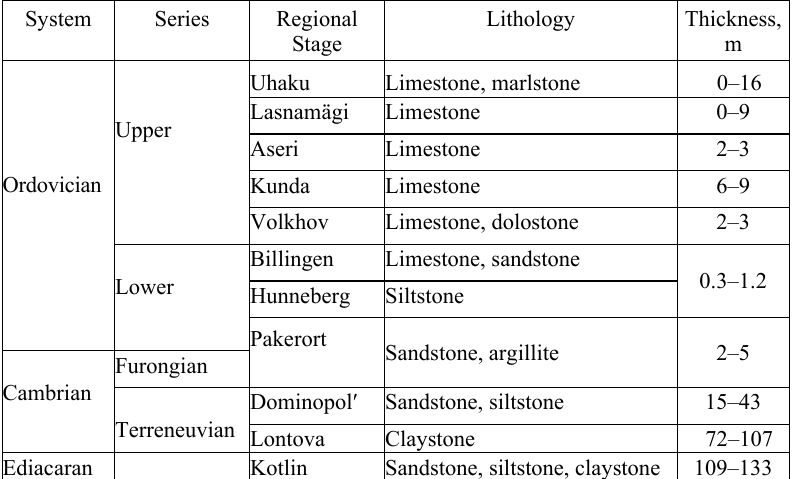
Table. 1. Sedimentary bedrock of the area (Raukas & Teedum(cid:228)e 1997; Ogg et al. 2008)